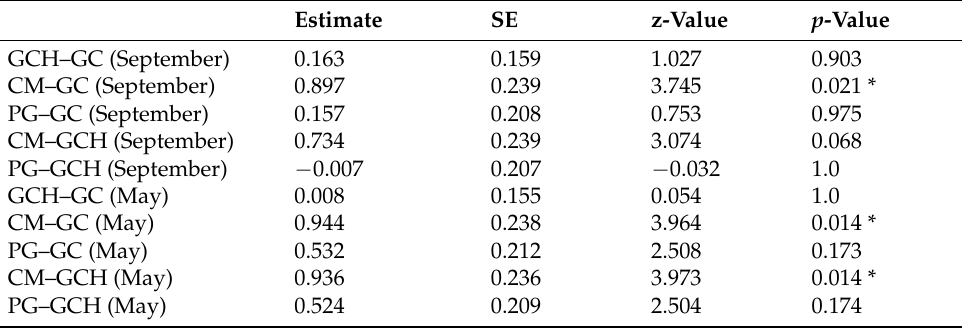
Table A7. Differences in the species richness of open-habitat carabid beetles, comparing grass–clover (GC) and grass–clover herbs (GCH) with each other, and in comparison to conventional maize (CM) and permanent grasslands (PG) in May/June and September. p -values are indicated as * p <